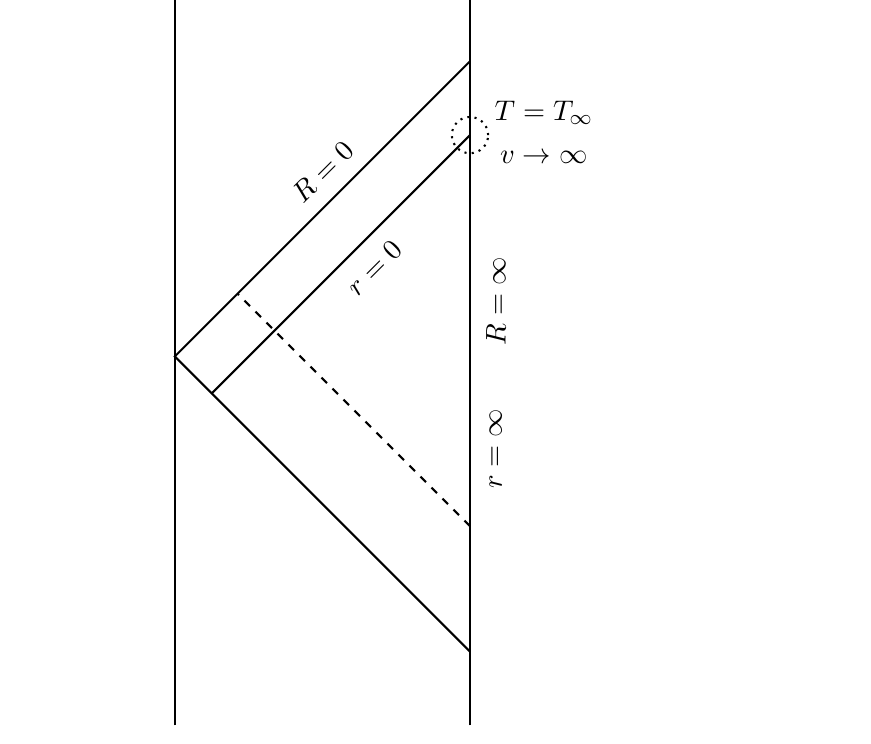
Figure 2 . Penrose diagram displaying the mapping (3.3). The coordinates f T; R g cover the Poincar(cid:19)e patch 0 < R < 1 with metric (2.4), while the coordinates f t; r g cover the Rindler patch 0 < r < 1 with metric (3.2). The dashed null line represents a possible initial data surface. The relation between f ( n ) and g ( n ) is determined by the boundary conditions.